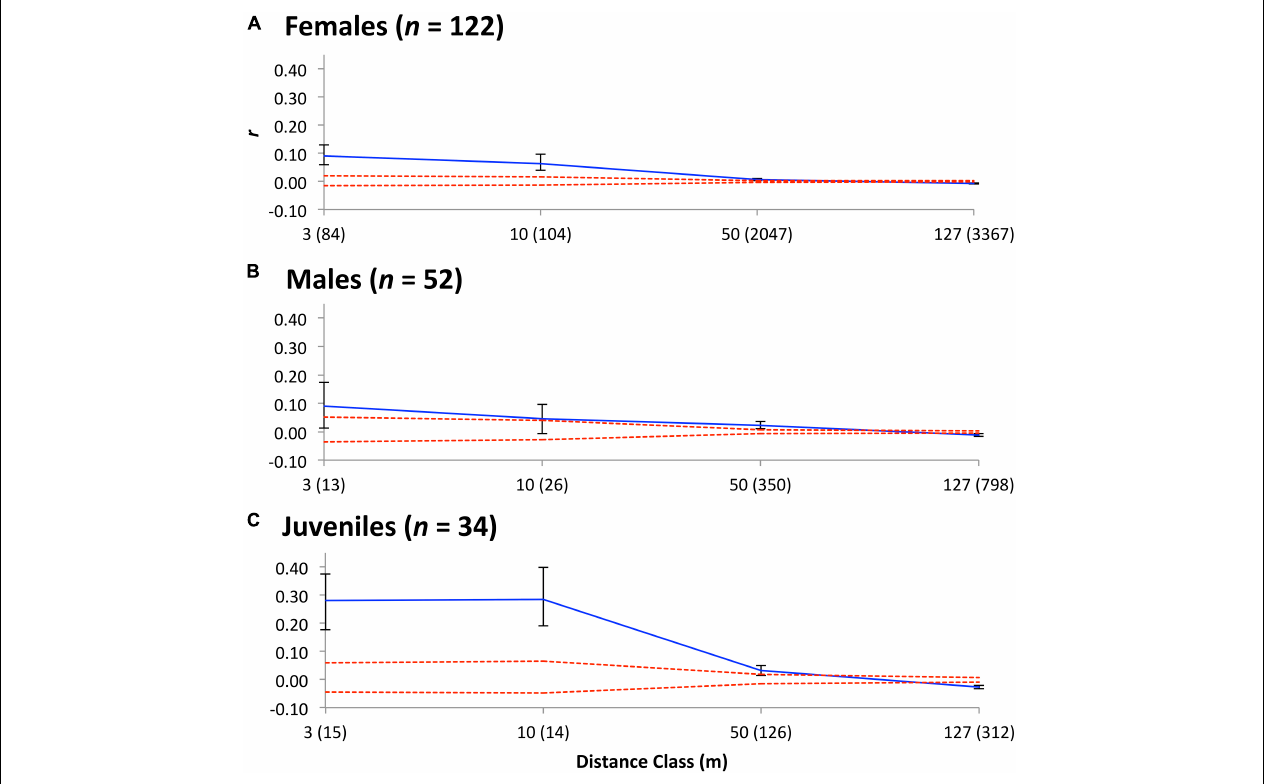
FIGURE 4 | Correlograms displaying the genetic correlation ( r ) for Tree Skink (A) adult females, (B) adult males, and (C) juveniles over a function of distance (m). Sample sizes at each distance are shown in brackets following each class label. Dotted lines represent 95% confidence intervals reflecting the null hypothesis of a random distribution of genotypes, which were determined with 10,000